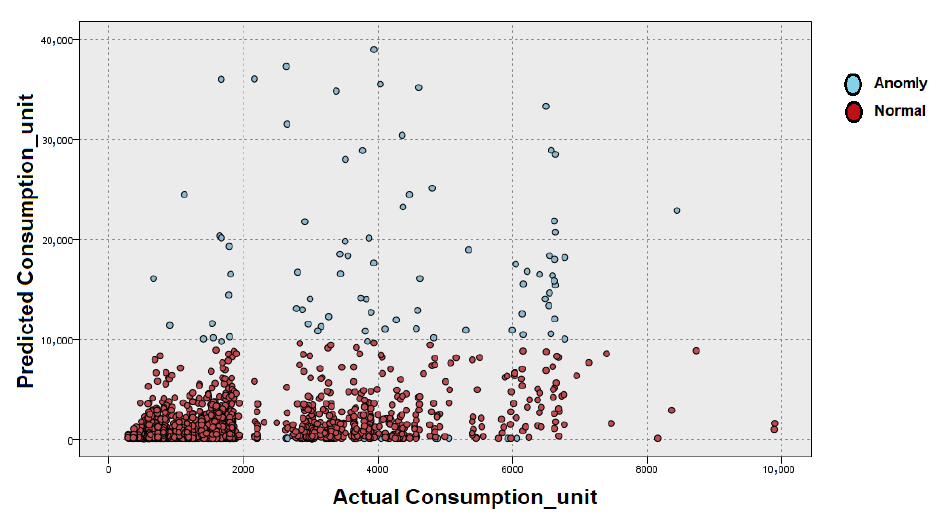
Figure 9. Anomaly detection graph created with the one-class